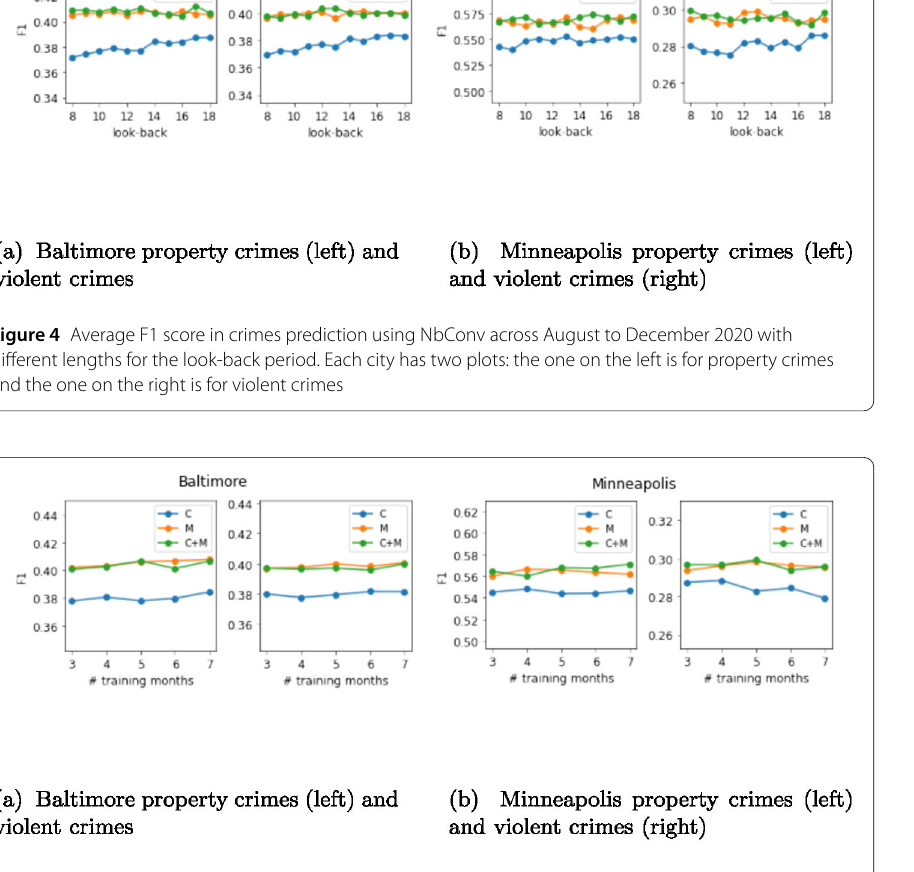
Figure 5 Average F1 score in crimes prediction using NbConv across August to December 2020 with different lengths for the look-back period. Each city has two plots: the one on the left is for property crimes and the one on the right is for violent